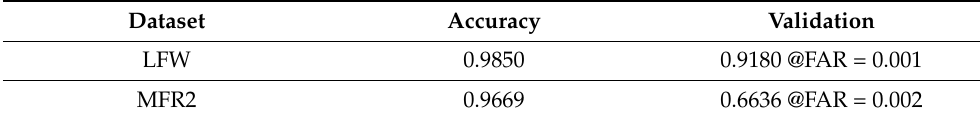
Table 4. Simulated CASIA-WebFace verification on different datasets.